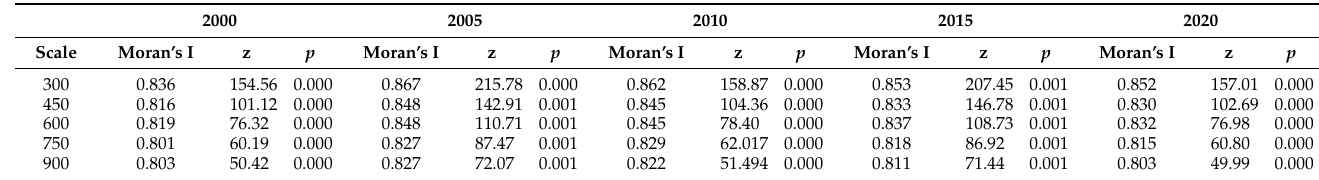
Table 4. RSEI Moran index at different scales.